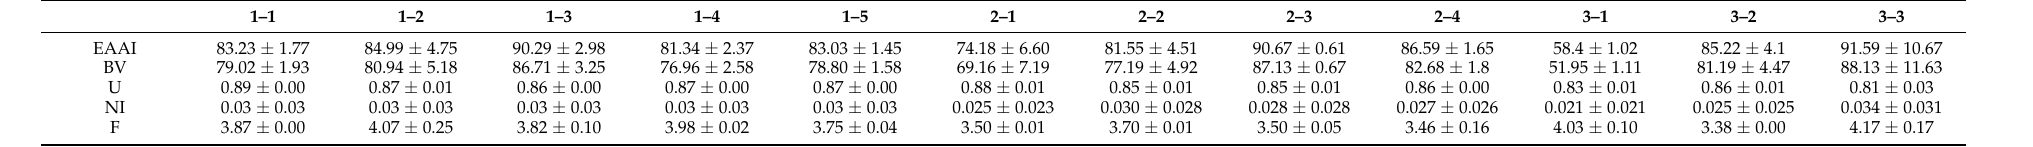
Table 7. EAAI, BV, U(a,u), NI, and F of fresh corn from three regions.